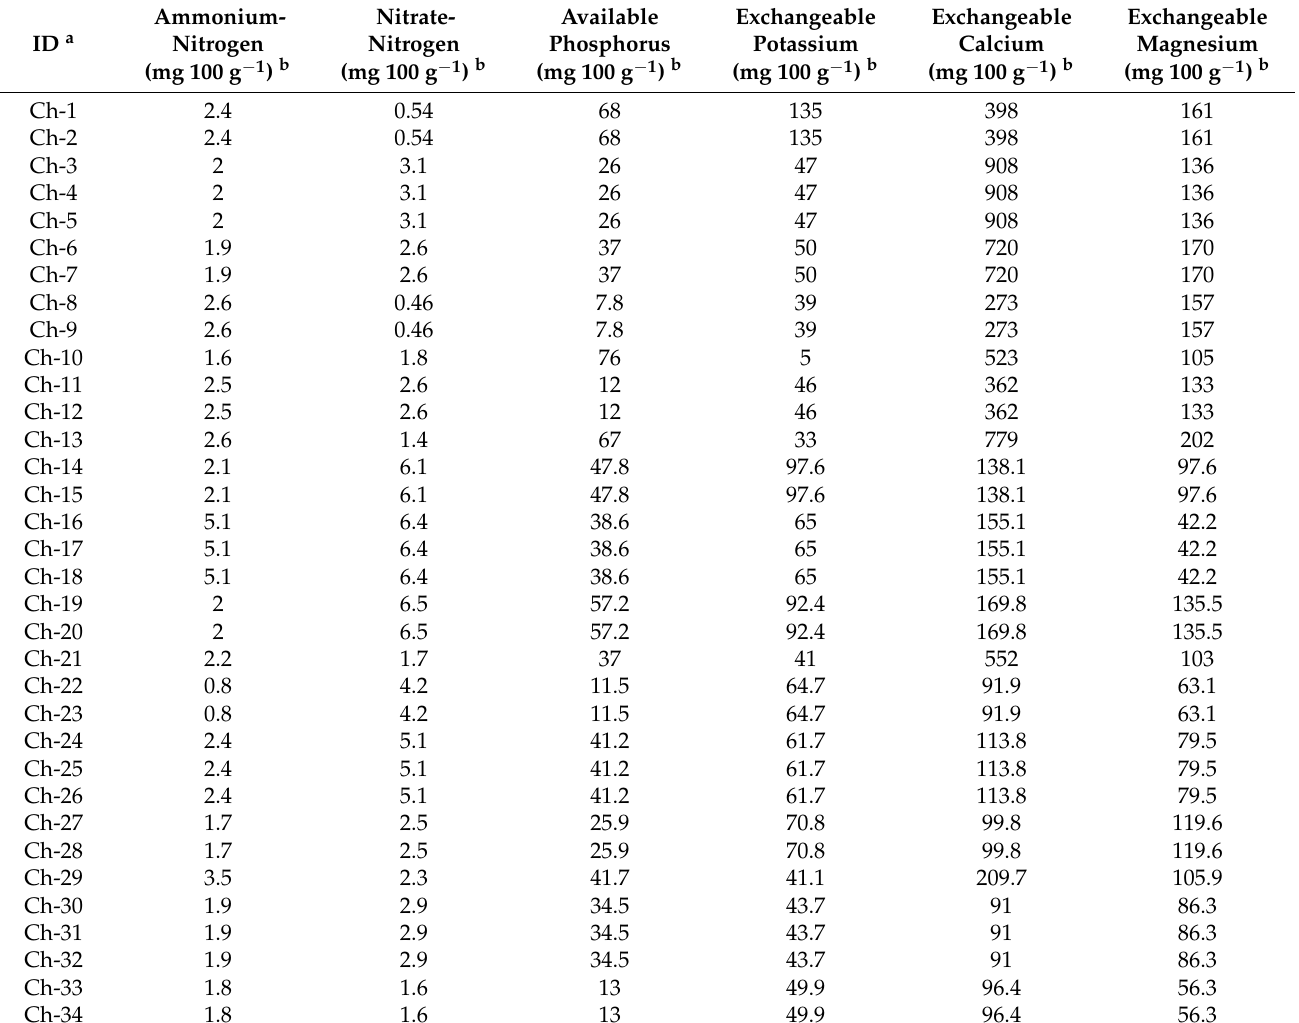
Table 1. Soil macronutrients from plant collection